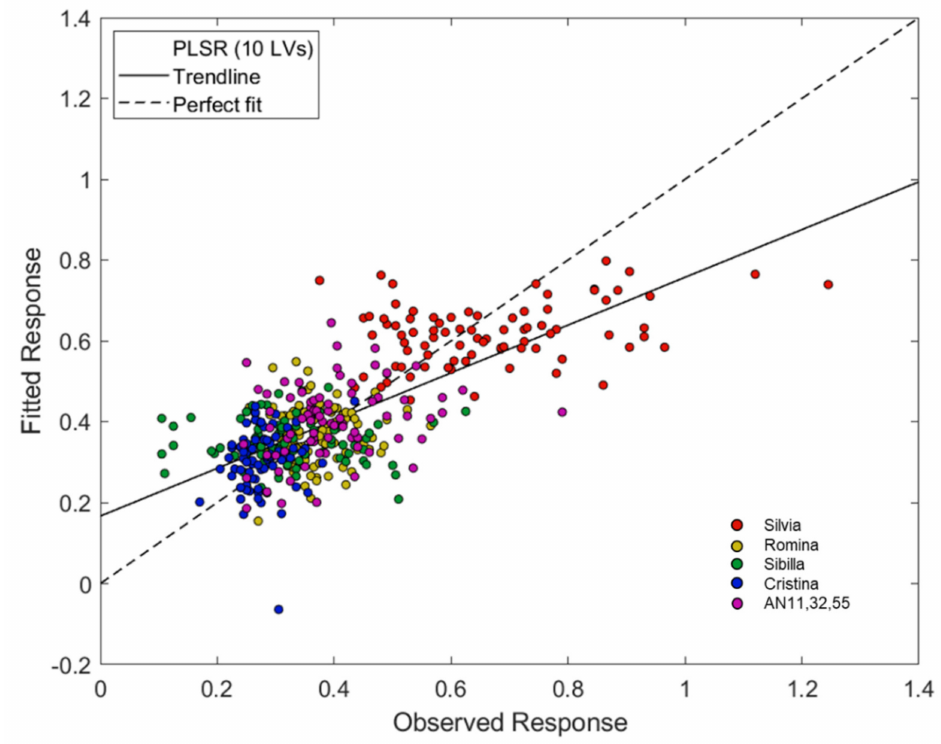
Figure 6. Regression plot of the Partial Least Squares Regression (PLS) model for the prediction of firmness obtained with Near Infrared (NIR) spectra pretreated with first derivatives (Savitzky–Golay filter. 21 smoothing points. 2nd polynomial